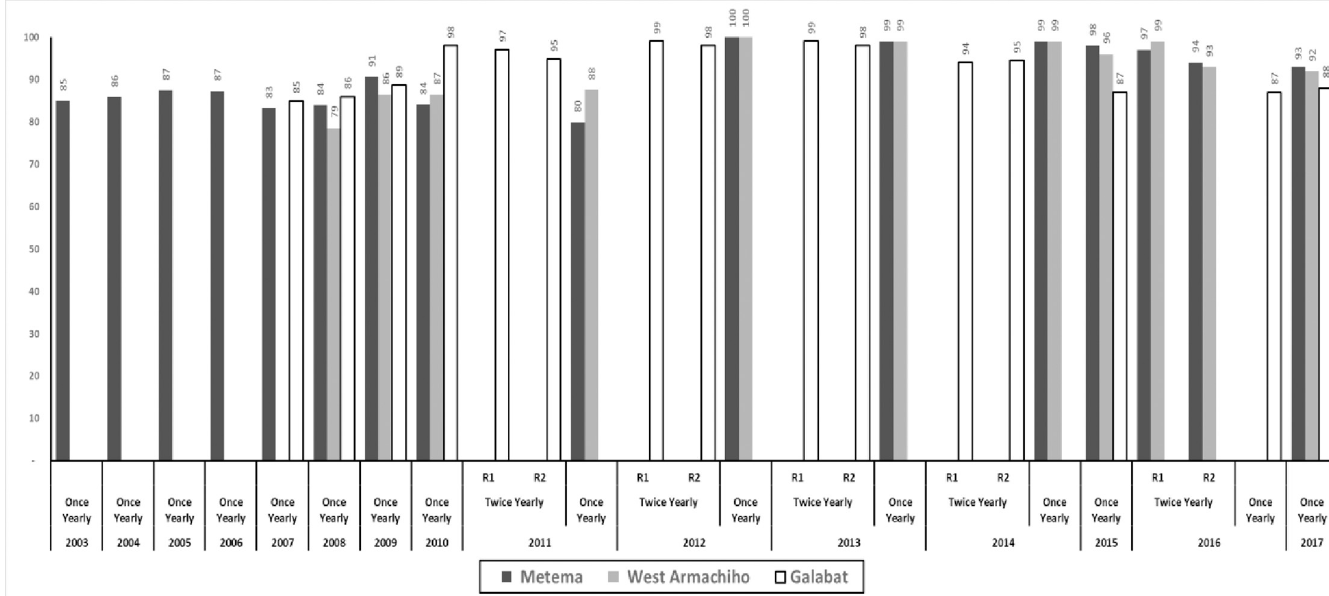
Fig 3. Treatment Coverage of the eligible population of ivermectin MDA provided once or twice yearly in Galabat subfocus and The Metema subfocus (Metema and West Armachiho districts), by year (2003–2017). Not copyrighted, and was created in Ms